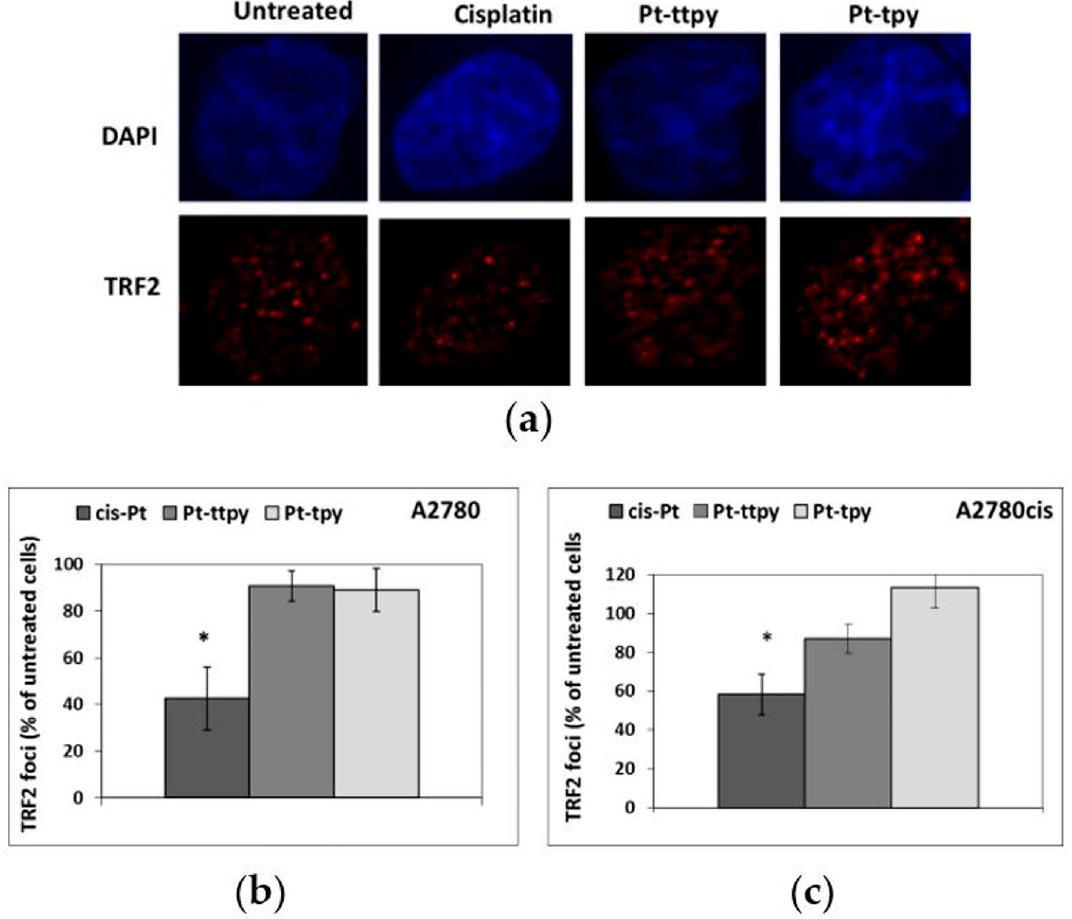
Figure 5. TRF2 foci quantification detected by immunofluorescence on A2780 and A2780cis cells treated with cisplatin, Pt-ttpy, and Pt-tpy for 8 h at 50 µM; ( a ) A2780 cells were processed for immunofluorescence using antibodies against TRF2; ( b ) % of TRF2 foci after A2780 cell treatments with cisplatin, Pt-ttpy, and Pt-tpy ( c ) % of TRF2 foci after A2780cis cell treatments with cisplatin, Pt-ttpy, and Pt-tpy (mean of at least three experiments). * Indicates a Mann and Withney test p -value p < 0.05 (GraphPad PRISM software, RITME, Paris, France).